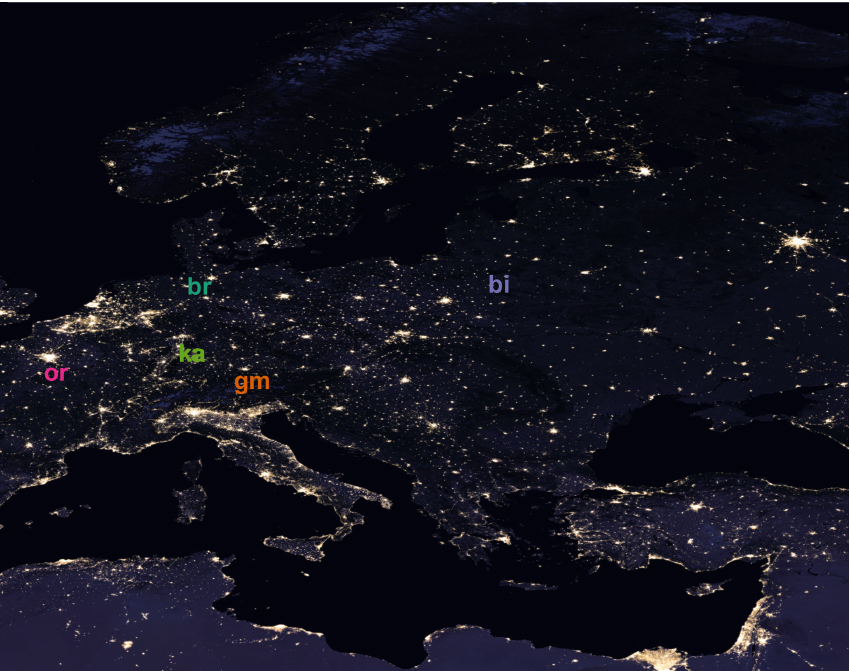
Figure 1. The locations of the TCCON observatories overlaid on a NASA nighttime light image. From west to east, the stations are Orléans (or, pink), Karlsruhe (ka, green), Bremen (br, blue-green), Garmisch-Partenkirchen (gm, orange), and Białystok (bi,